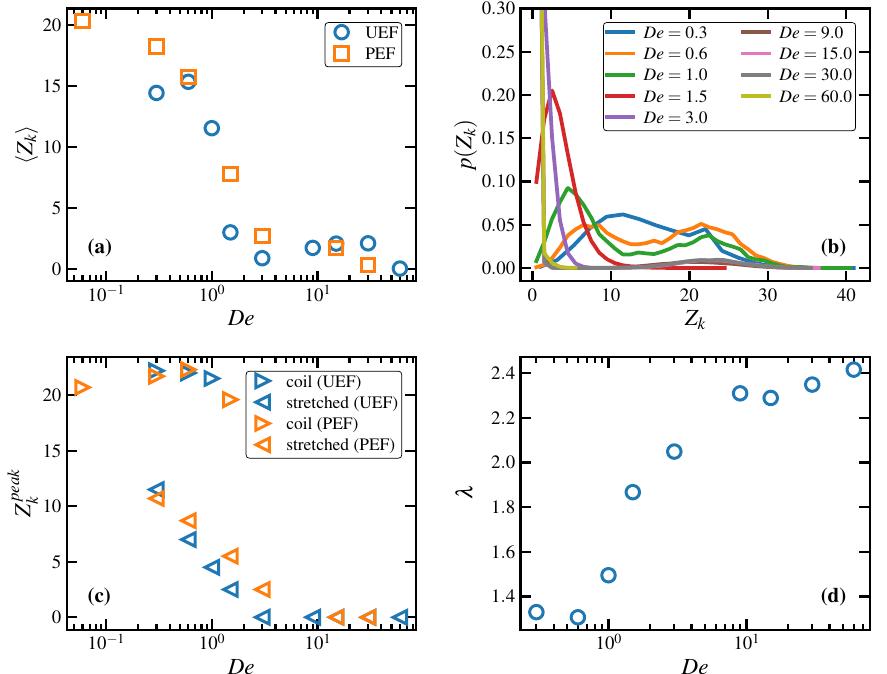
Figure 5. Steady-state topological characteristics of the C 1000 H 2002 melt undergoing UEF and PEF: ( a ) average number of chain kinks per molecule vs. De ; ( b ) probability distributions of Z k at various De (UEF only); ( c ) peak positions of the PDFs of panel ( b ) plotted vs. De , including those of the same melt undergoing PEF (which are not shown in panel ( b ); and ( d ) tube stretch vs. De under UEF only. Note that the PDFs of De 9.0 in panel ( b ) all overlap each ≥